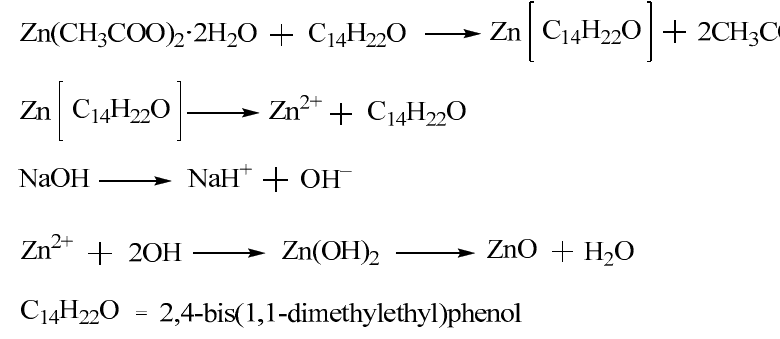
Scheme 2. Mechanism of green synthesis of ZnO NPs.